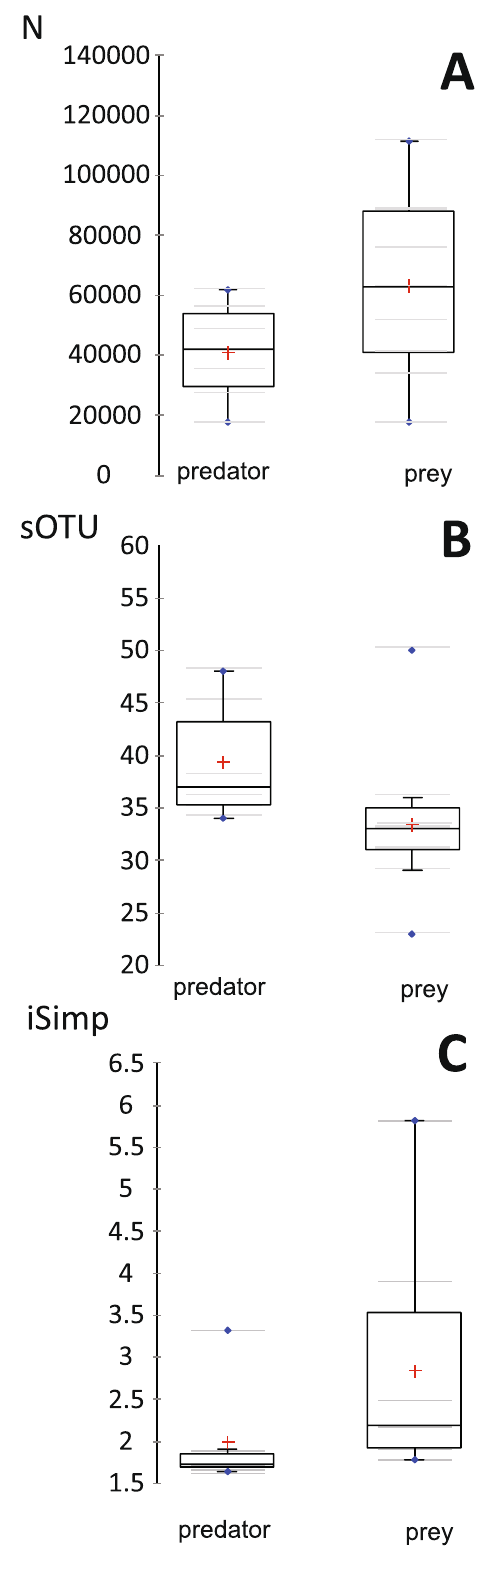
Figure 2. Comparisons of beta-diversity between bacterial microbiota from N. cucumeris compared to T. putrescentiae . ( A ) Number of sequences analyzed across samples; ( B ) Species Richness, number of species-level OTUs across samples; ( C) Inverse Simpson Diversity Index comparing predatory vs. prey mites (see Table 1 for description of